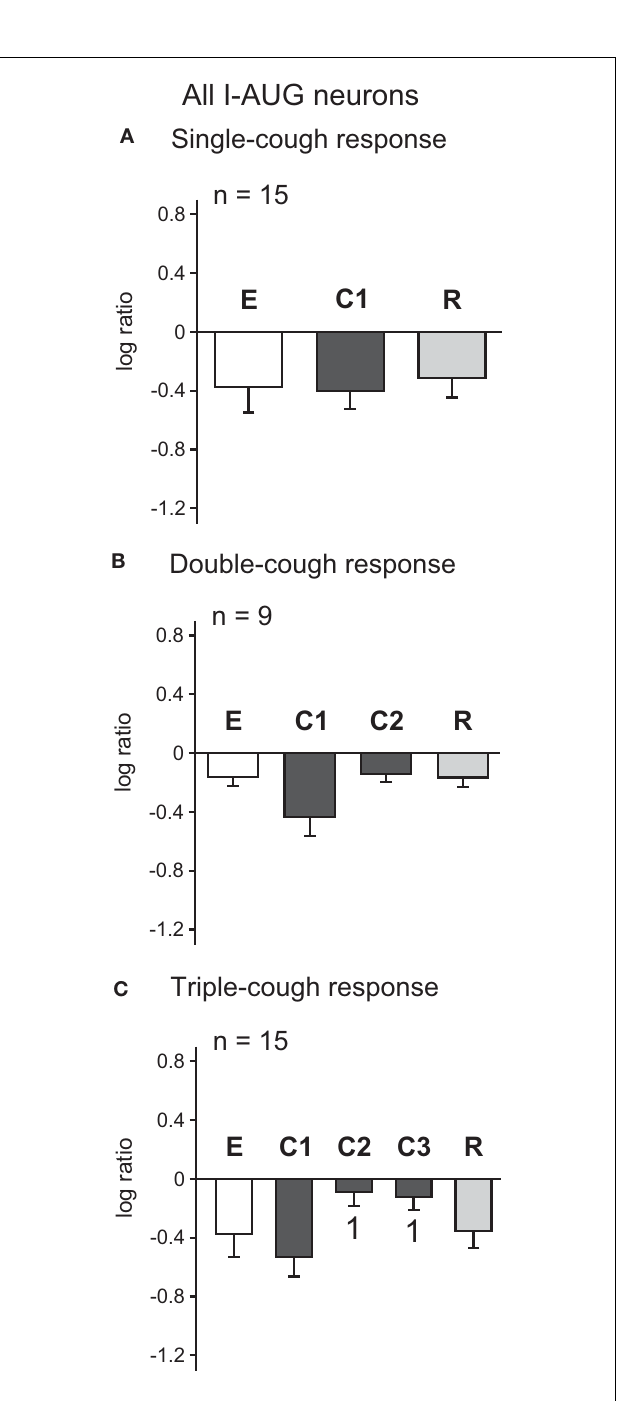
FIGURE 3 |Average log ratios of I-Aug neurons during (A) single-, (B) double-, and (C) triple-cough episodes. 1, Significantly different from C1 ( p < 0.02). Number of neurons ( n ) analyzed for each cough episode type is indicated on the plots. Some neurons were evaluated for more than one type of cough response. Error bars indicate the standard error of the mean.